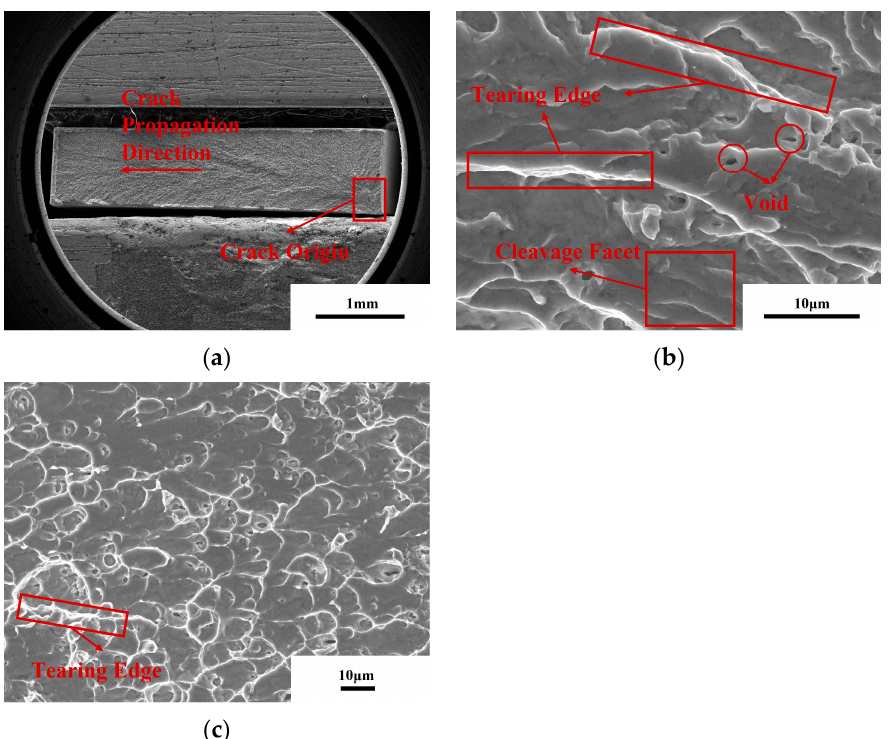
Figure 11. Fracture morphology after tensile test of alloy annealed at 500 °C for 60 min. ( a ) Low magnification morphology of fracture area; ( b ) crack propagation area; and ( c ) dimple region.